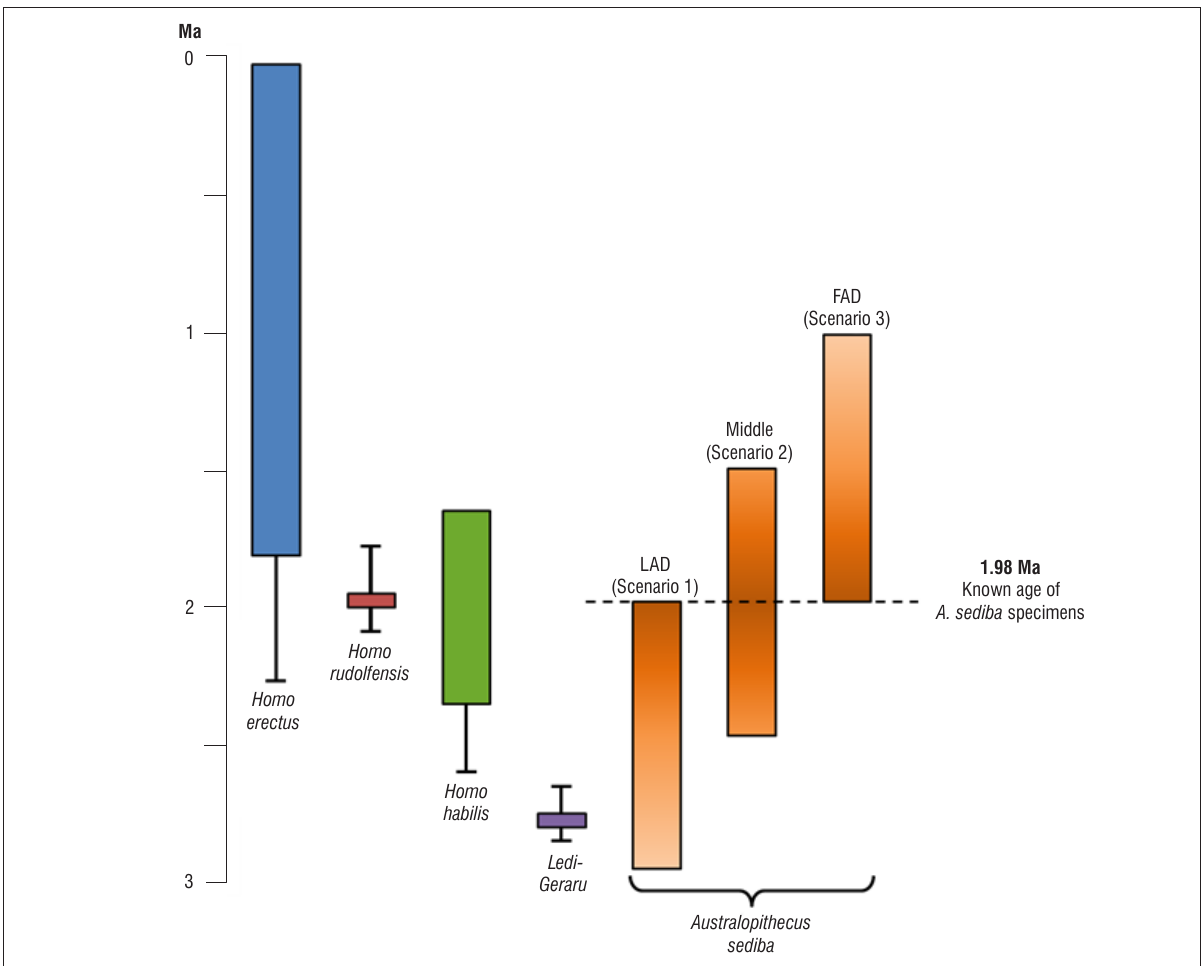
Figure 2: Estimates of the temporal ranges of the earliest species attributed to the genus Homo and potential durations for Australopithecus sediba assuming the Malapa specimens represent the last appearance date (LAD; Scenario 1), the middle of the species actual temporal range (Scenario 2) or first appearance date (FAD; Scenario 3) using an average hominin temporal duration of 0.97 Myr. Data used to generate the figure are from Table 1. Solid bars represent ranges using the ‘conservative’ data set while error bars incorporate both the ‘with error’ data and a lumping of the ‘low confidence’ taxa from Wood and Boyle 56 . Graded shading on the bars for A. sediba indicates the greater degree of uncertainty that the taxon existed at the time